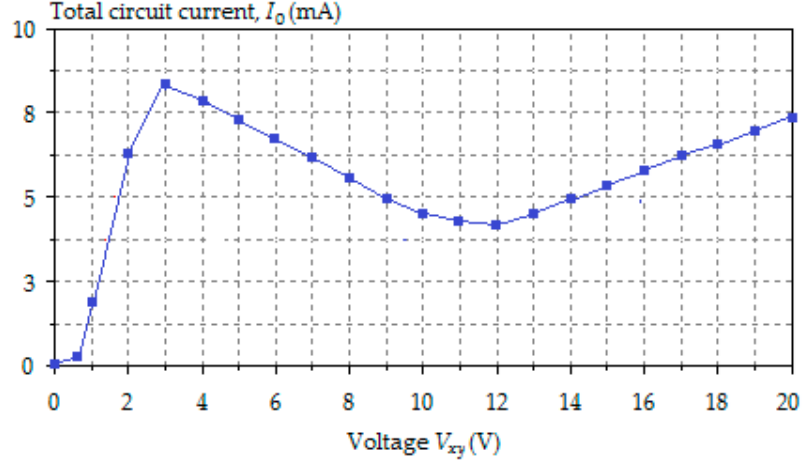
Figure 9. Measured current-voltage characteristics of the implemented NDR oscillator.